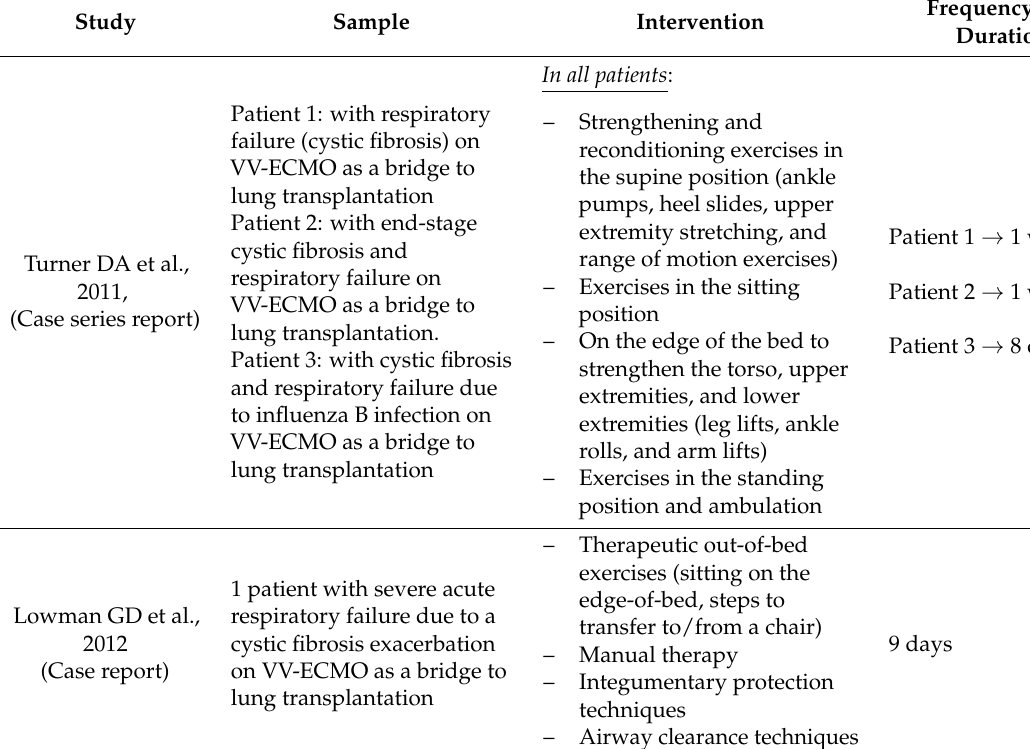
Table 1. Studies including mobilization in ECMO patients—sample size, intervention characteristics, outcomes, main results and